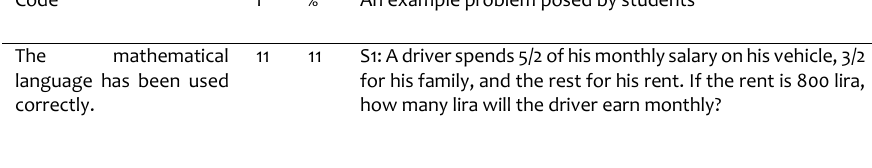
Table 4 . Examination results of the problems in terms of mathematical language Code f % An example problem posed by students